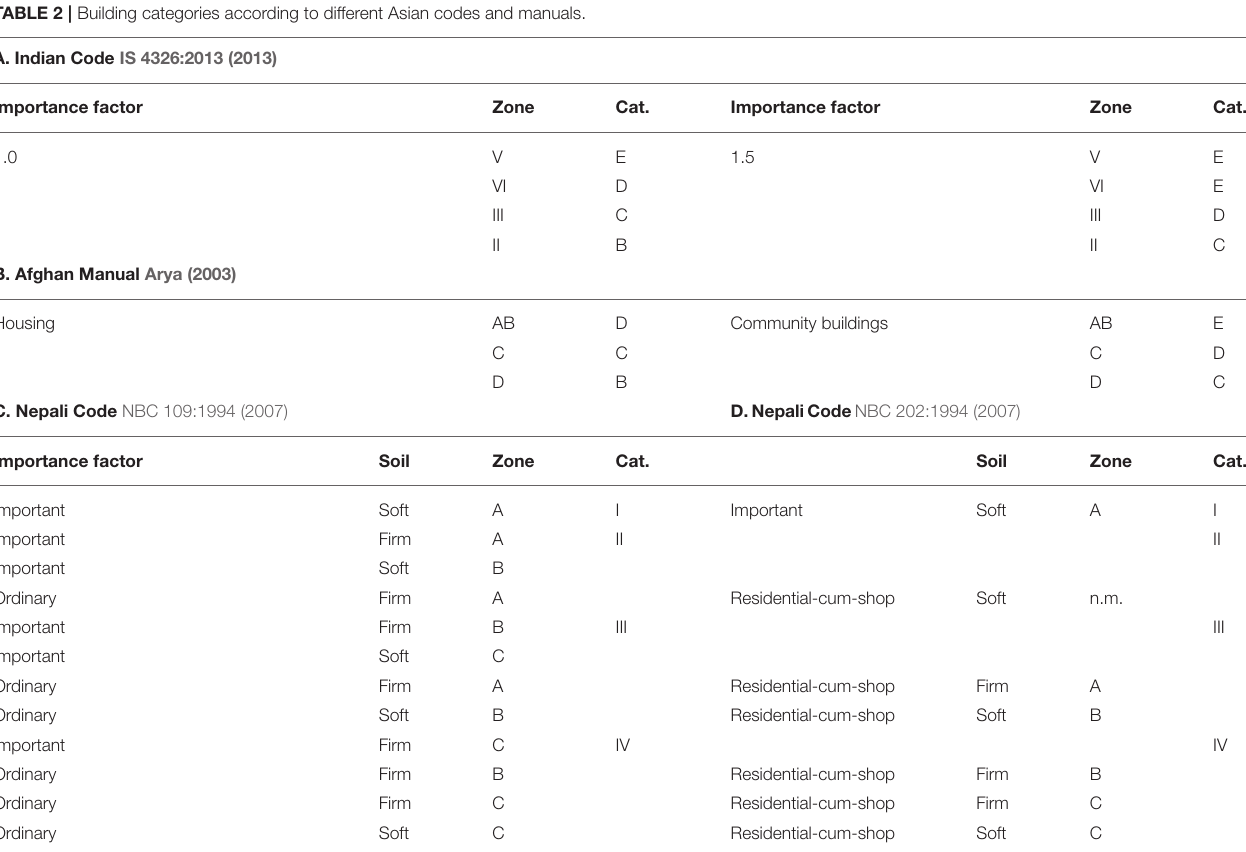
TABLE 2 | Building categories according to different Asian codes and